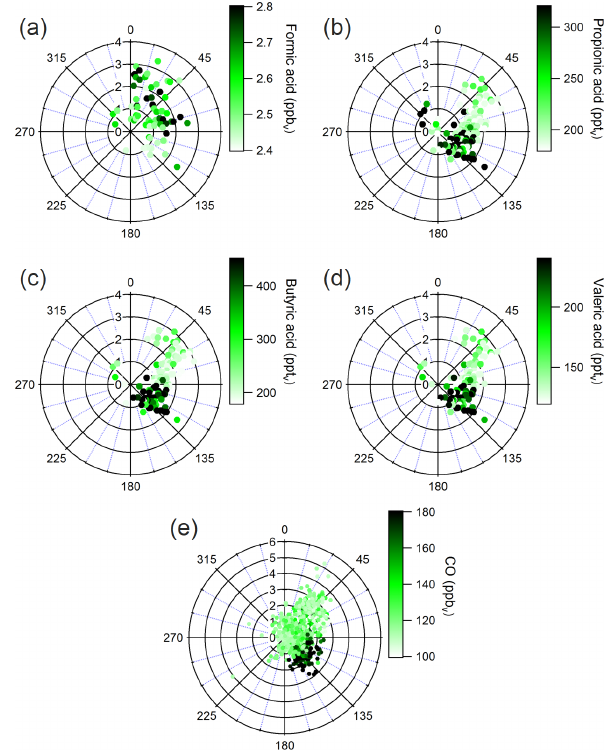
Figure 4. Wind plots of (a) formic acid, (b) propionic acid, (c) bu- tyric acid, (d) valeric acid, and (e) CO measured at the site. Data are selected during periods of morning rush-hour traffic (08:30– 10:30MDT). Data points are colored by mixing ratio. Radial and angular axes represent wind speed (ms − 1 ) and direction (degrees), respectively. Degrees correspond to cardinal directions (i.e., 0 ◦ is N, 90 ◦ is E,